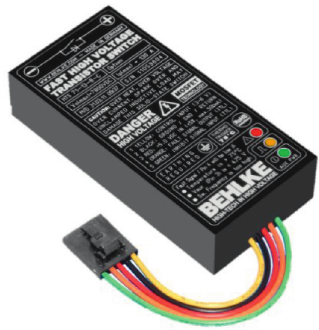
Figure 4: The compact series of the fast high-voltage transistor switch using MOSFET technology by Behlke power